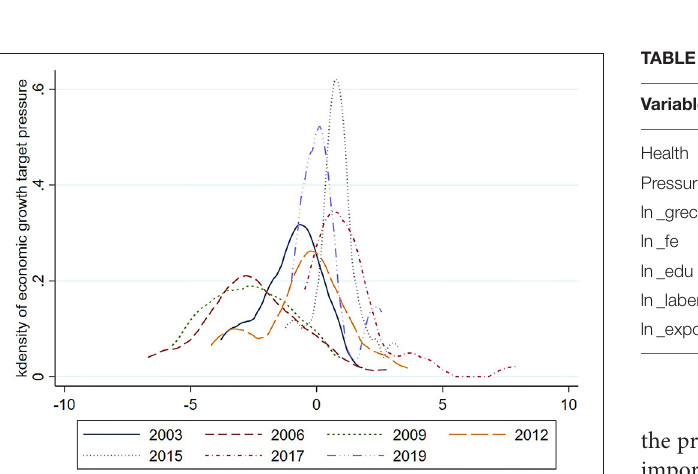
FIGURE 2 | GDP and GDP target pressure in developed region and less developed region.